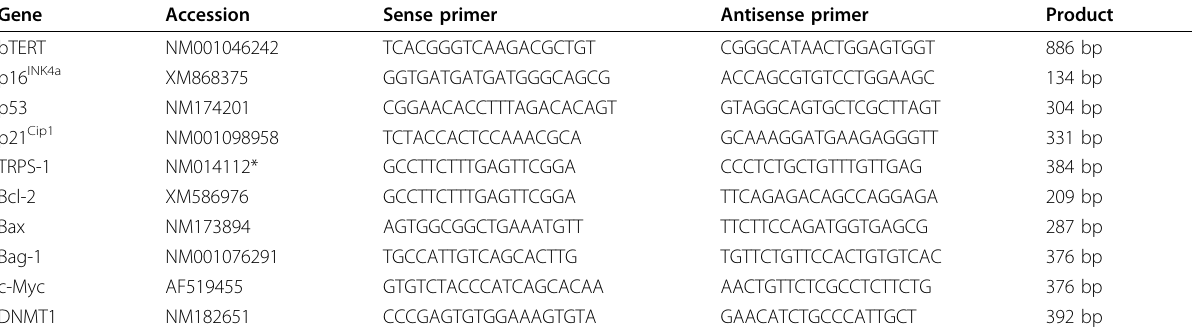
Table 1 Primer pairs used in the real-time PCR experiments of gene expression profiles Primer pairs applied for real- time